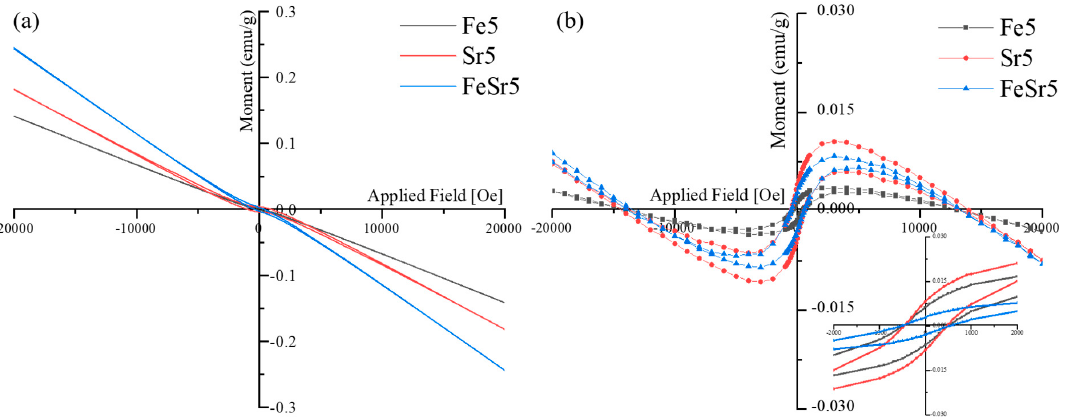
Figure 9. Magnetization curves of various β− TCP powders annealed at 800 °C. ( a ) origin graph, ( b ) diamagnetic behavior subtraction graph.